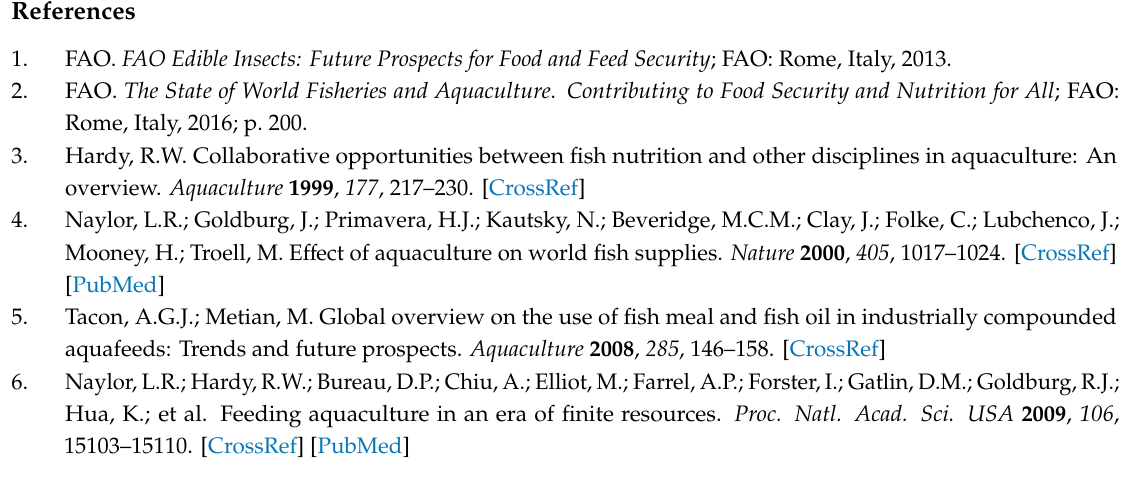
Table S1: List of OTUs and corresponding number of reads found in trout intestinal mucosa samples. Author Contributions: Conceptualization and methodology, G.T., S.R., L.G.; Data collection, curation and